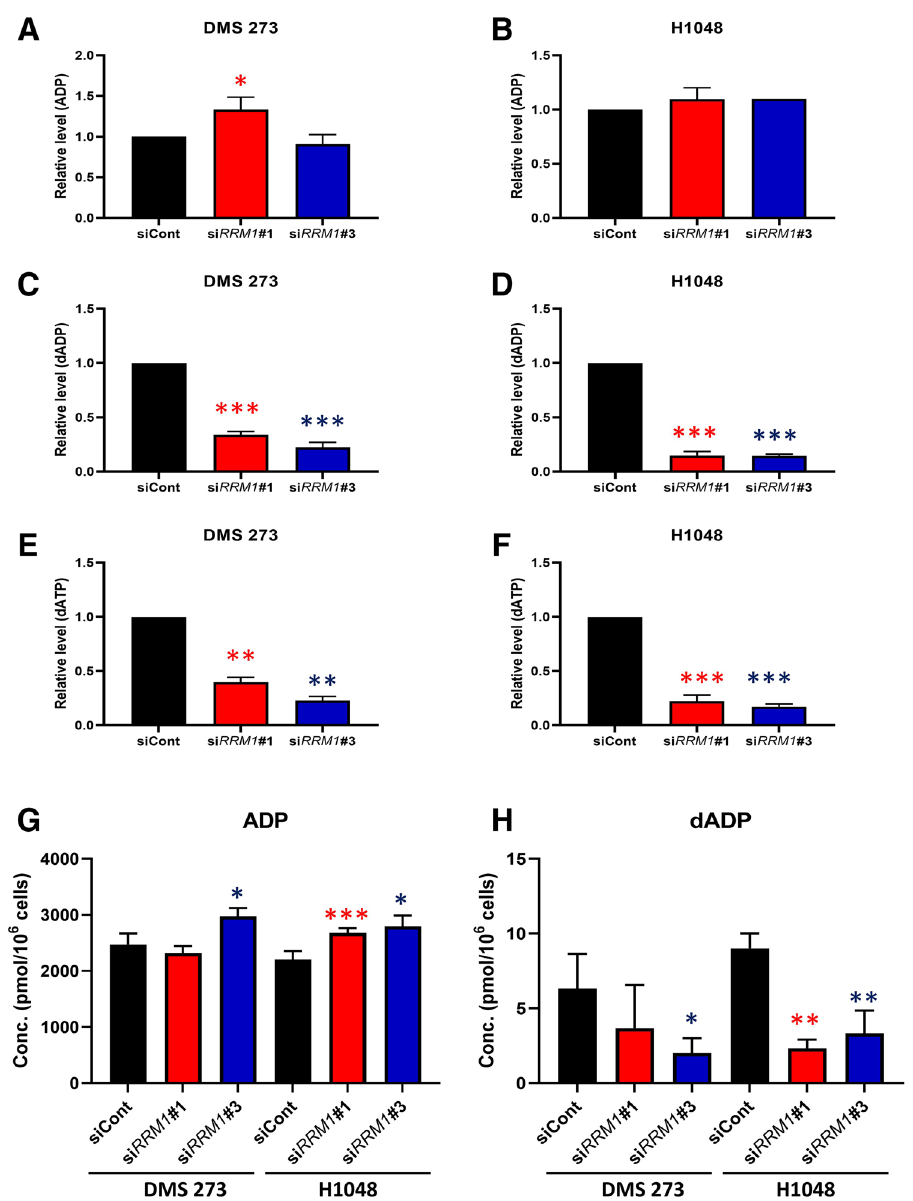
Figure 6. RRM1 knockout decreased dNTP levels in SCLC cells. A – F , relative intracellular levels of key metabolites in the nucleotide biosynthesis pathway after RRM1 inhibition. The representative metabolites ADP, dADP, dATP, and ATP are shown here; however, others are listed in Supplementary Table S2. Data represent the mean ± SD ( n = 3). Black: siCont, red: si RRM1 #1, blue: si RRM1 #3. Welch t -test and p values are indicated as *, < 0.05; **, < 0.01; and ***, < 0.001. G and H , intracellular concentrations (pmol/10 6 cells) of ADP and dADP after RRM1 inhibition in DMS 273 ( G ) and H1048 ( H ) cells. Data represent the mean ± SD ( n = 3). Black: siCont, red: si RRM1 #1, blue: si RRM1 #3. * p < 0.05, ** p < 0.01, *** p < 0.001 vs. control, Welch t